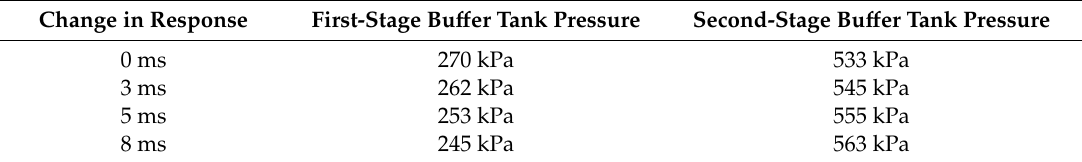
Figure 12. ( a ) First-stage exhaust buffer tank; ( b ) second-stage exhaust buffer tank. Table 4. Buffer tank pressure variation under different responses of the solenoid valve.